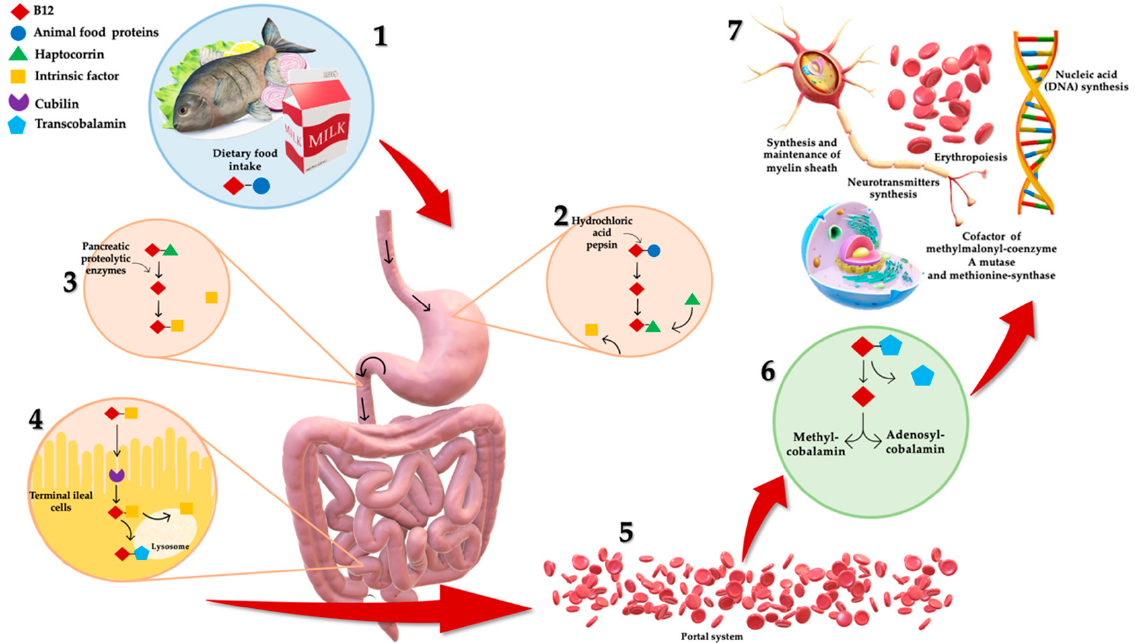
Figure 1. Complex mechanism of B12 absorption, metabolism and functions. (1) Dietary B12 is obtained through animal foods. (2) B12 release takes place in the stomach by means of hydrochloric acid and pepsin. Here, it is bounded to haptocorrin, forming a protein-complex. (3) Once arrived in duodenum, B12 is released from its protein-complex due to pancreatic proteolytic enzymes. Free B12 is then bound by intrinsic factor (IF). (4) B12–IF complex reaches terminal ileum where it is absorbed. Afterward, the complex is degraded in lysosomes and B12 is bound to transcobalamin, forming transcobalamin–B12 complex. (5) B12 is transported via the portal system in this complexed form, (6) and it is uptaken and accumulated by body cells, where it is converted to metabolic active forms: Methylcobalamin and Adenosylcobalamin. (7) B12 is crucial for several physiologic functions: erythropoiesis, synthesis and maintenance of myelin sheath, DNA and neurotransmitters synthesis, and intracytoplasmic cofactor.